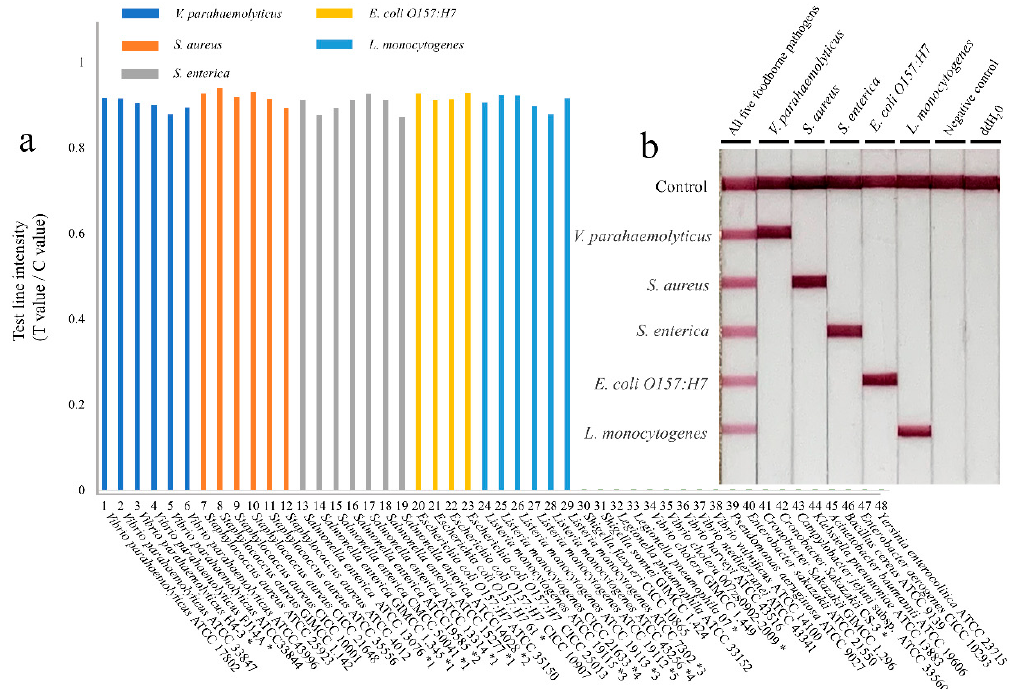
Figure 4. Specificity testing of the RPA-LFIA assay. ( a ) Results of the specific evaluation of the 48 foodborne strains. ( b ) Specific test results on the lateral flow dipstick. “*”: Presented by Zhoushan Entry-Exit Inspection and Quarantine Bureau, without serotype identification. “*1”: Serovar Enteritidis; “*2”: Serovar Typhimurium; “*3”: Serotype 4b; “*4”: Serotype 1/2a; “*5”: Serotype 1/2c.